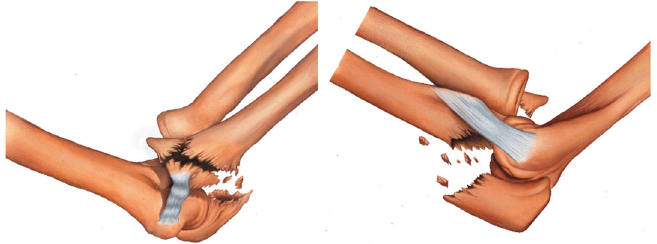
Figure 4. Type IIA fracture—transolecranon fracture of the proximal ulna with associated fracture of the sublime tubercle.